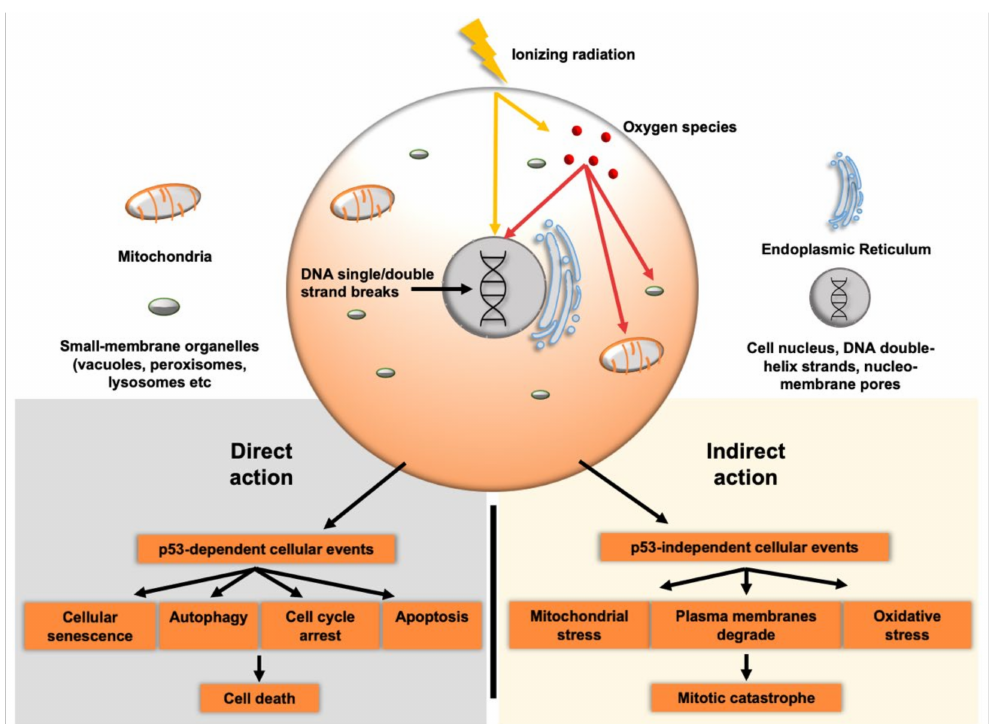
Figure 1. Cellular effects of ionizing radiation. Ionizing radiation directly damages DNA within targeted cells, causing both single and double strand DNA strand damage. Oxygen species are also created that cause DNA damage and disrupt lipid membrane components of the cell. Both the direct and indirect actions of radiation therapy cause downstream effects that lead to mitotic catastrophe and cell